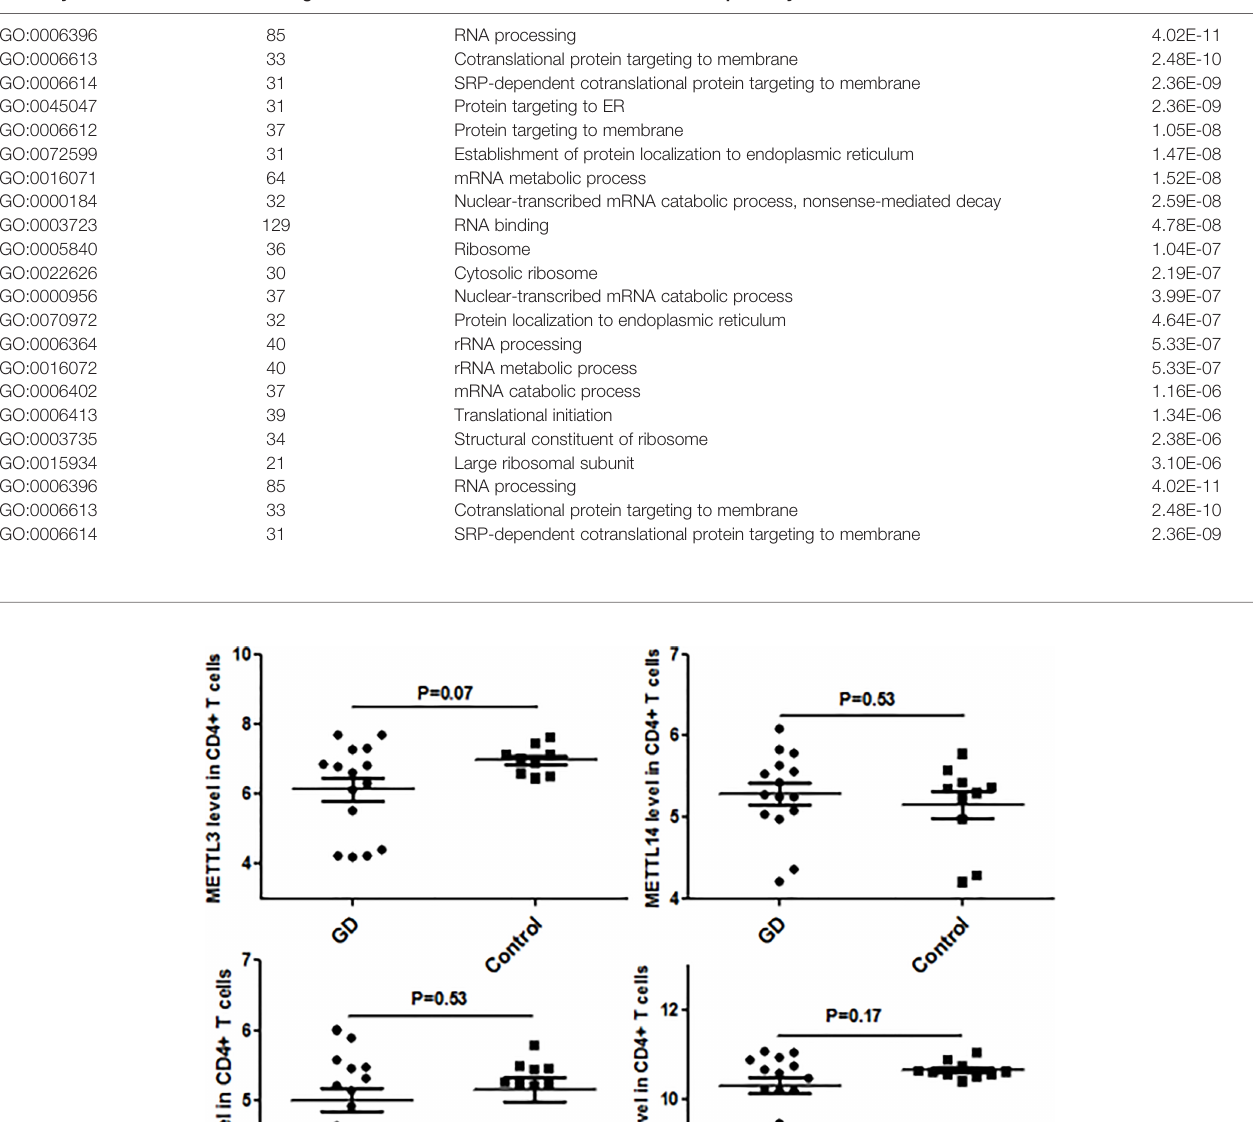
TABLE 2 | GD related key gene co-expression modules — green module gene function riched GO pathway. Pathway ID